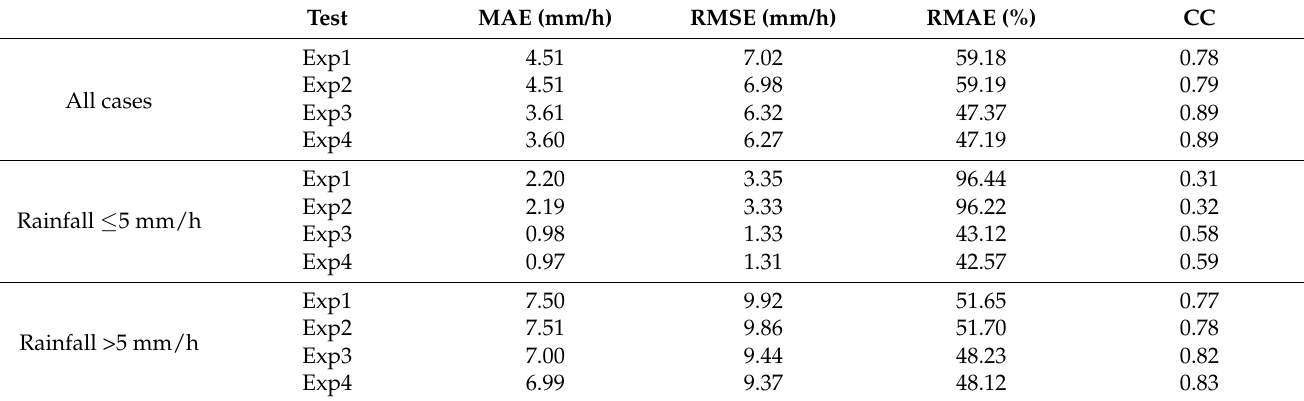
Table 3. Error statistics of QPE by R ( K DP ).